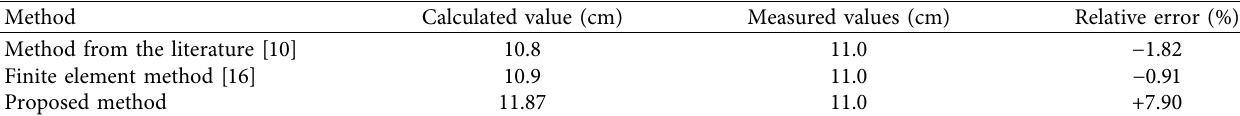
Table 2: Calculation results of different methods.